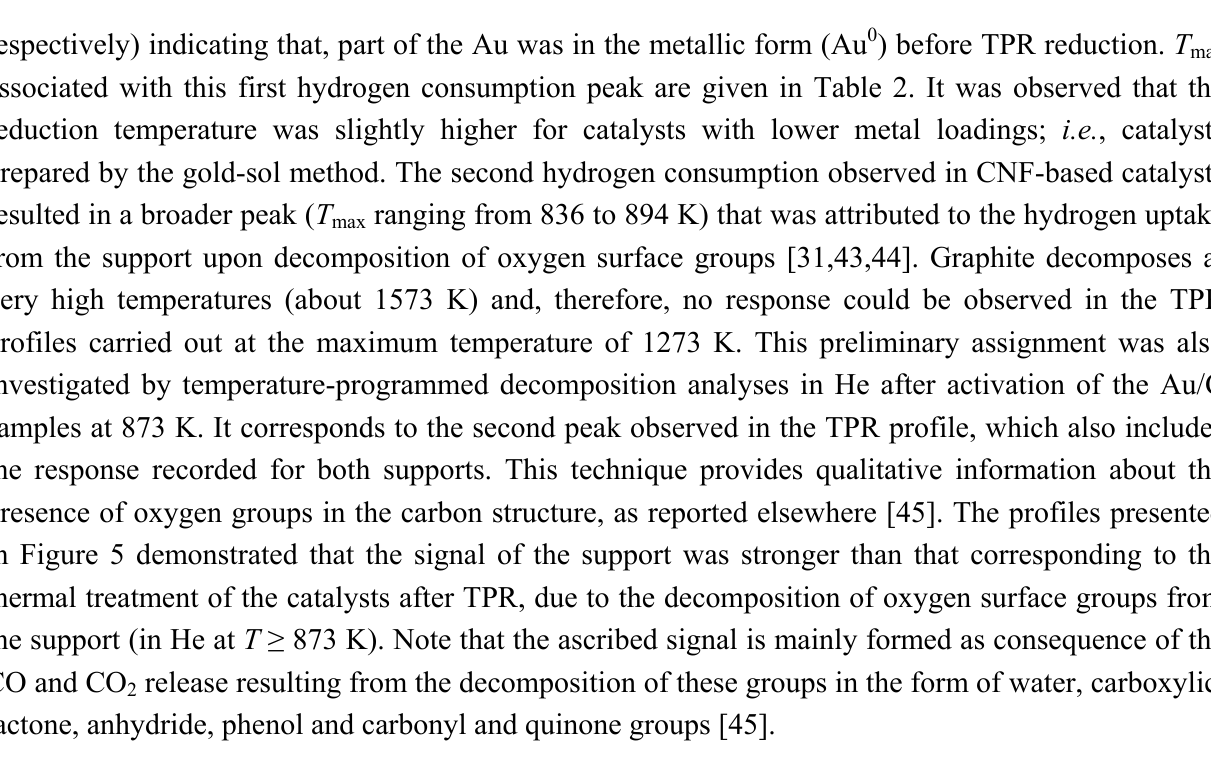
Table 2. Physicochemical properties of the Au-based